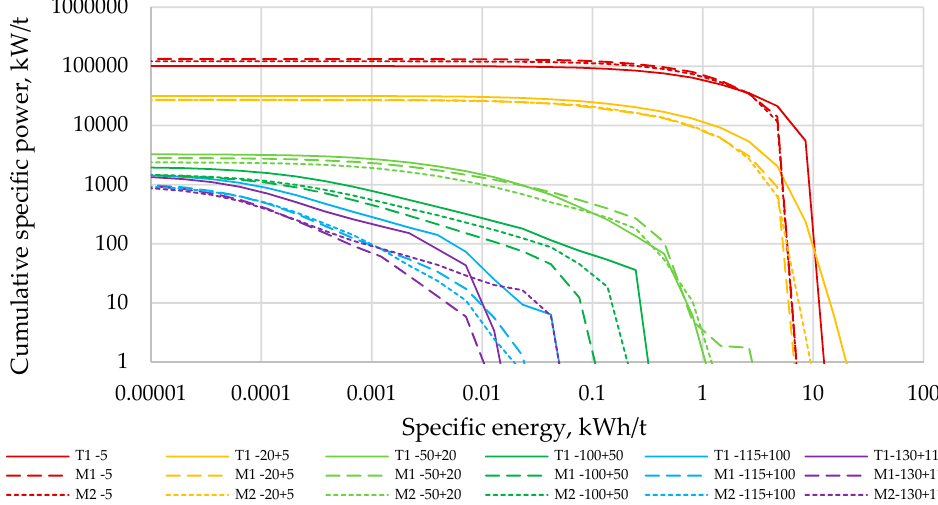
Figure 13. Energy spectra obtained by modeling.